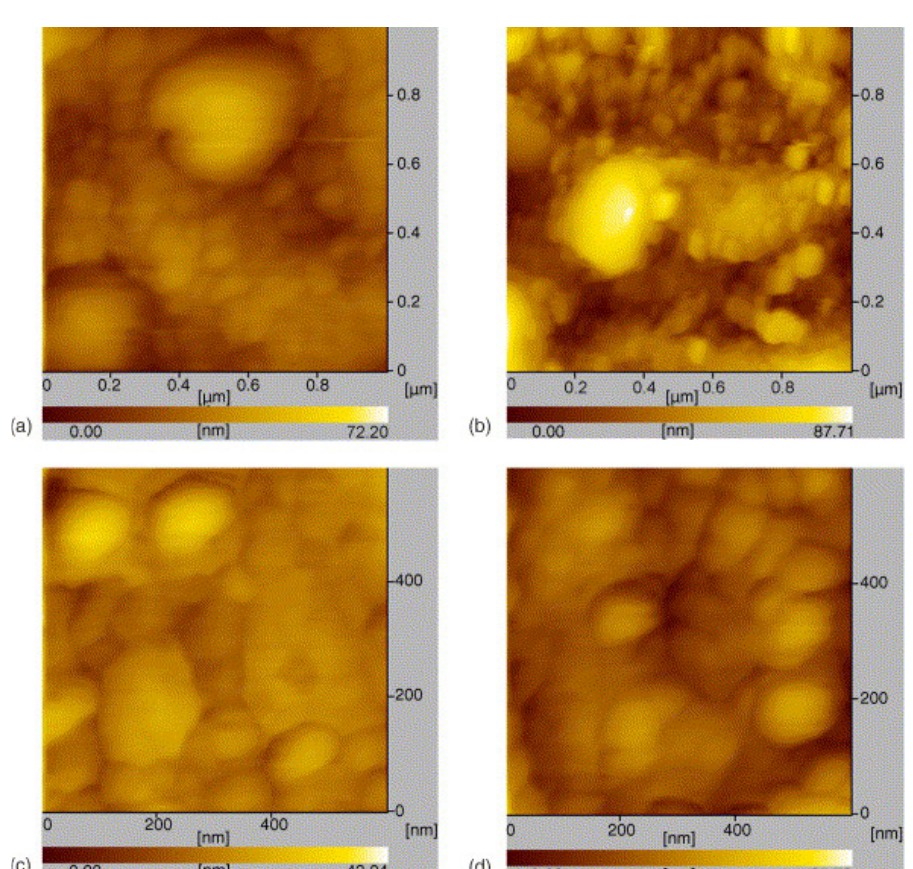
Figure 9. AFM images of characteristic interfacial microstructures at different WC-Co contents ( a ) 20 wt% of WC-10%Co; ( b ) 40 wt% of WC-10%Co, and ( c – f ) 30 wt% of WC-10%Co in WC-10%Co particle reinforced Cu matrix nanocomposites